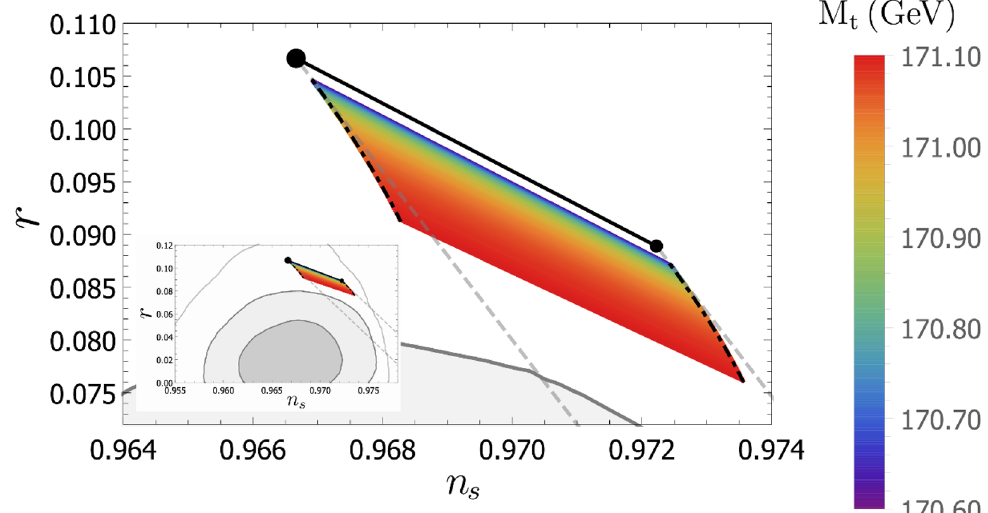
Figure 5 . ( n s ; r ) predictions for Case B without threshold corrections and for (cid:11) 0 = 1. The dashed line represents the analytic approximation of eq. (5.6). We have zoomed in on the Planck plot since the in(cid:13)ationary observables are less RG dependent than in case A. This outcome can be explained (see main text) by looking at (cid:12)gure